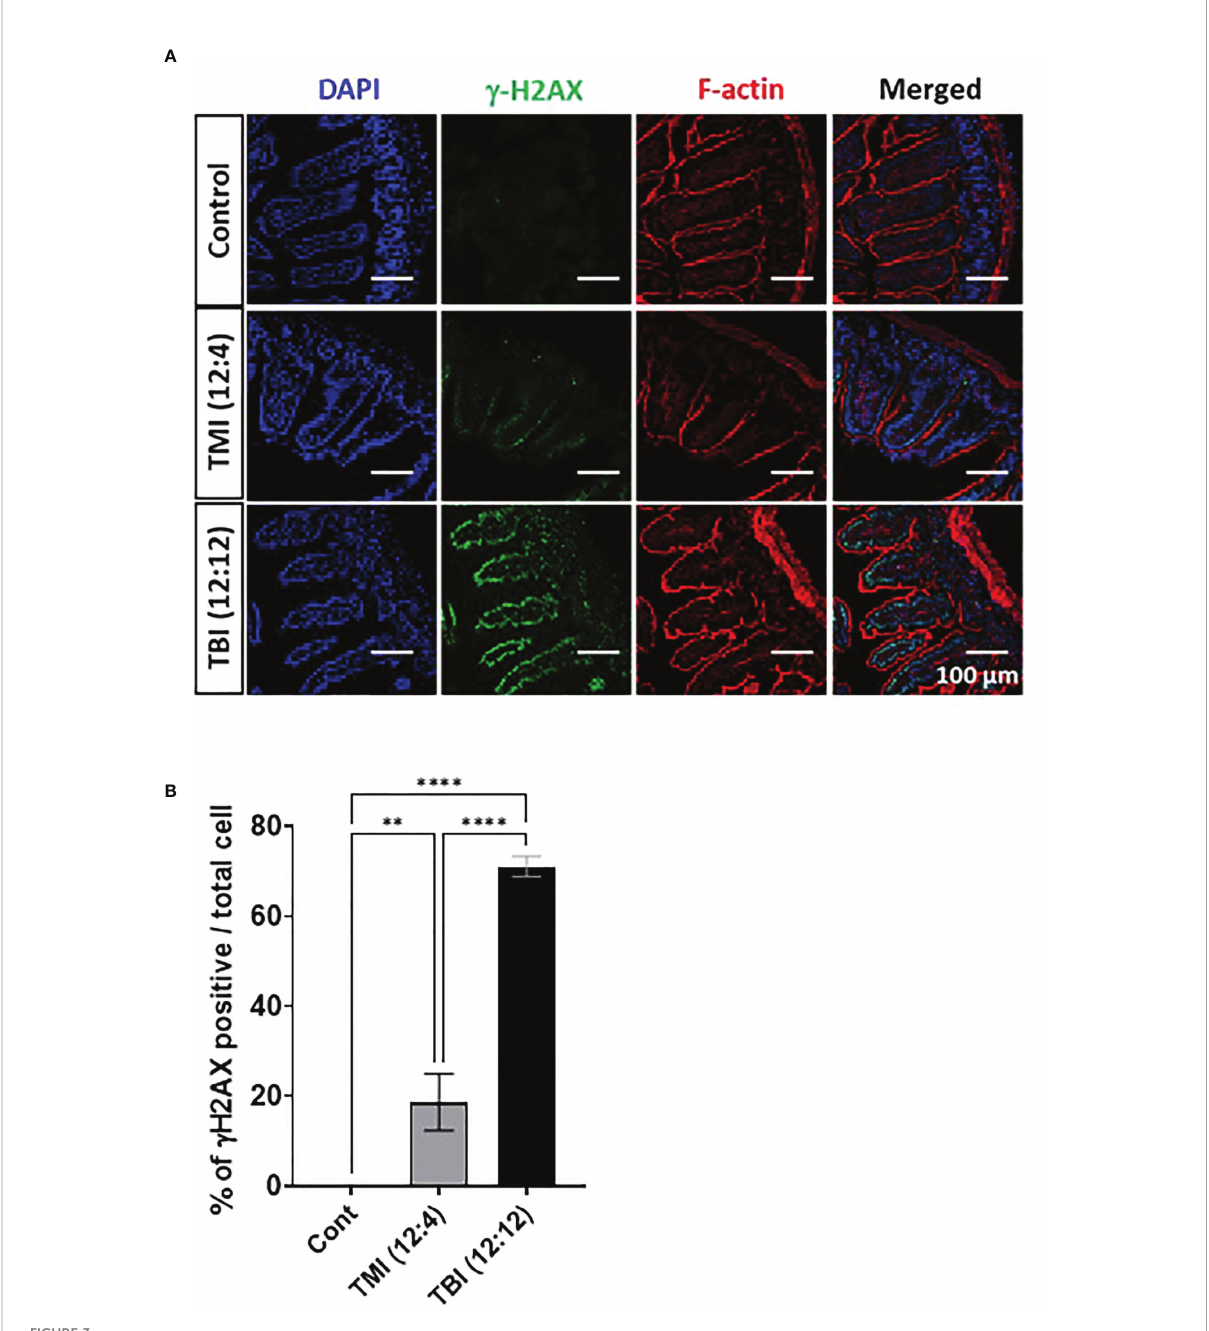
FIGURE 3 TMI reduces acute DNA damage than TBI. The mice were treated with TMI and TBI and 5 h post Rx DNA DSB was assessed by staining for g H2AX by immuno fl uorescence. (A) Immuno fl uorescence staining of g H2AX at 5h after irradiation. (Green = g H2AX, Red = F-actin, Blue = DAPI). (Young control, n=4; TMI (12:4), n=4; TBI (12:12), n=4) (B) Percentage of g H2AX positive cells/total cells. Three fi elds in each section and 2 different tissue sections from 4 mice in each group were used for calculations. Enlarged images are shown in Supplementary Figure S6. (**< 0.01, ****<0.0001, unpaired t test). Scale bar = 100 µm (A)